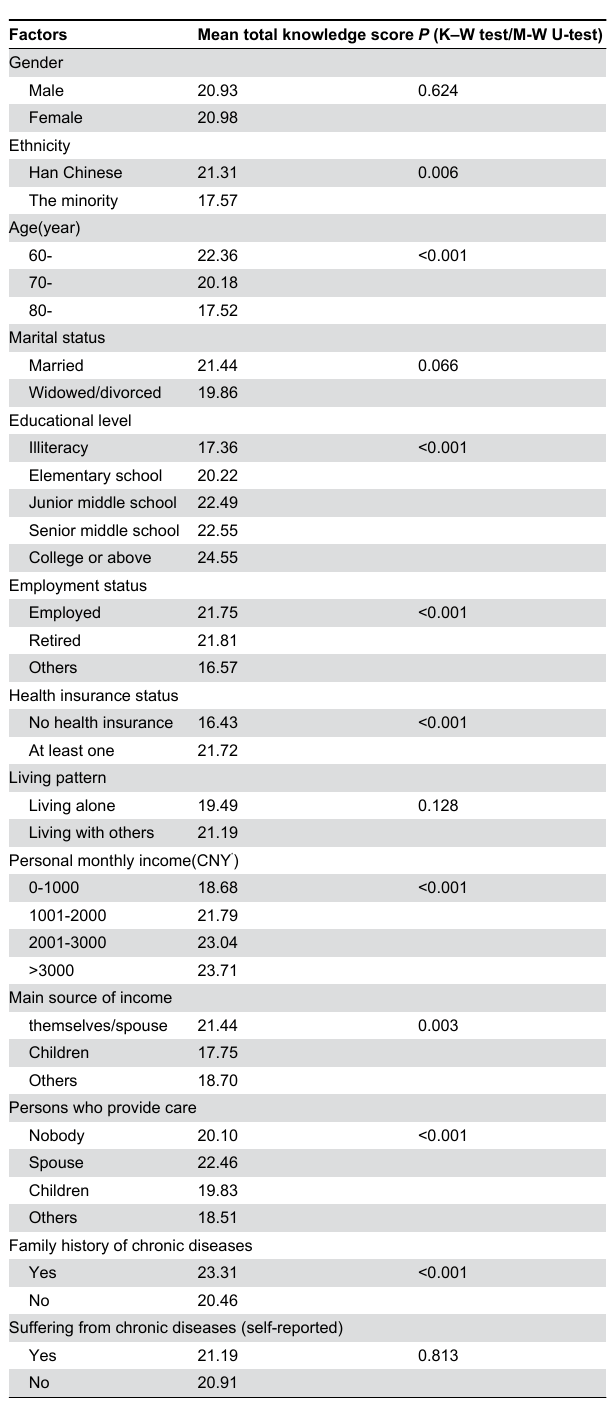
Table 3. Comparison of total knowledge among the elderly in Jinan with different